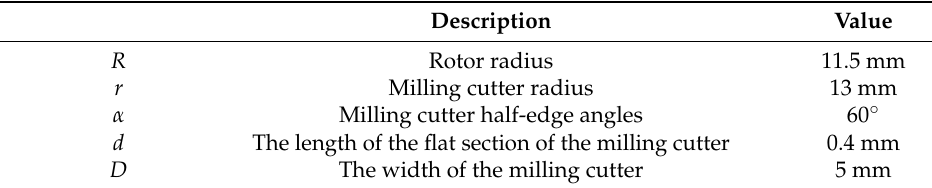
Table 1. Micro-motor armature and milling cutter parameters.